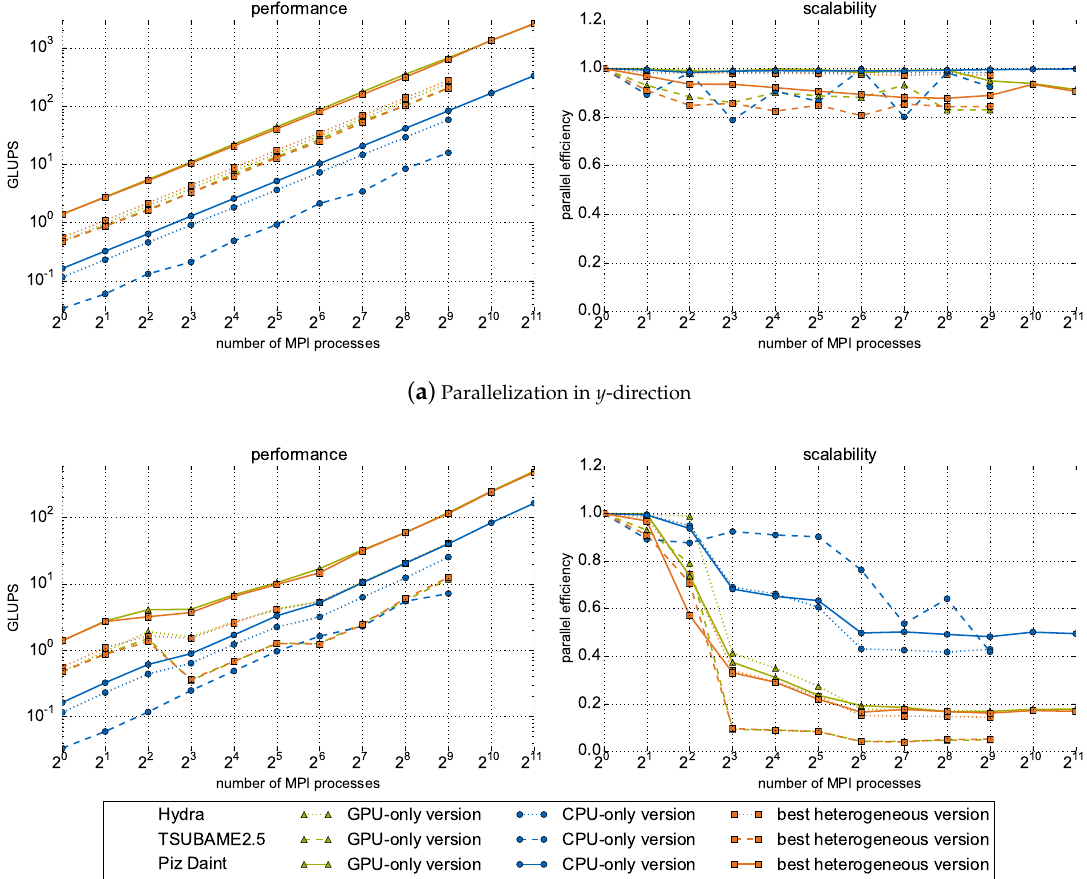
Figure 10. Weak scaling performance in GLUPS (left) and scalability expressed by parallel efficiency (right) for two different parallelization strategies. ( a ) Depicts results for parallelization in y -direction, ( b ) for parallelization in x / y / z -direction. Degree of parallelism expressed by number of subdomains is assigned to the ordinates. Different line markers denote different CPU/GPU heterogeneous clusters. The CPU-only homogeneous version is colored in blue, the GPU-only homogeneous version in green, and the best performing heterogeneous version in